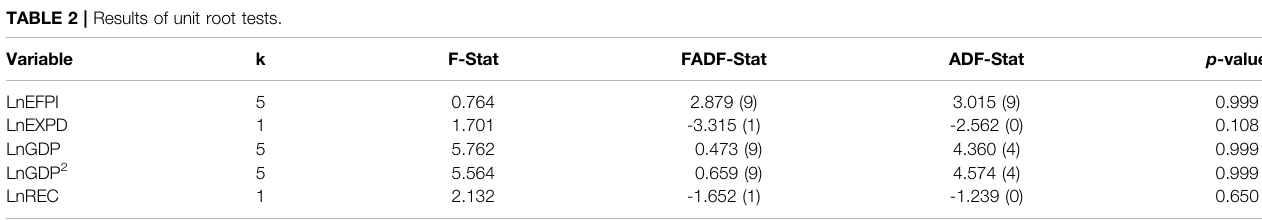
TABLE 2 | Results of unit root tests.